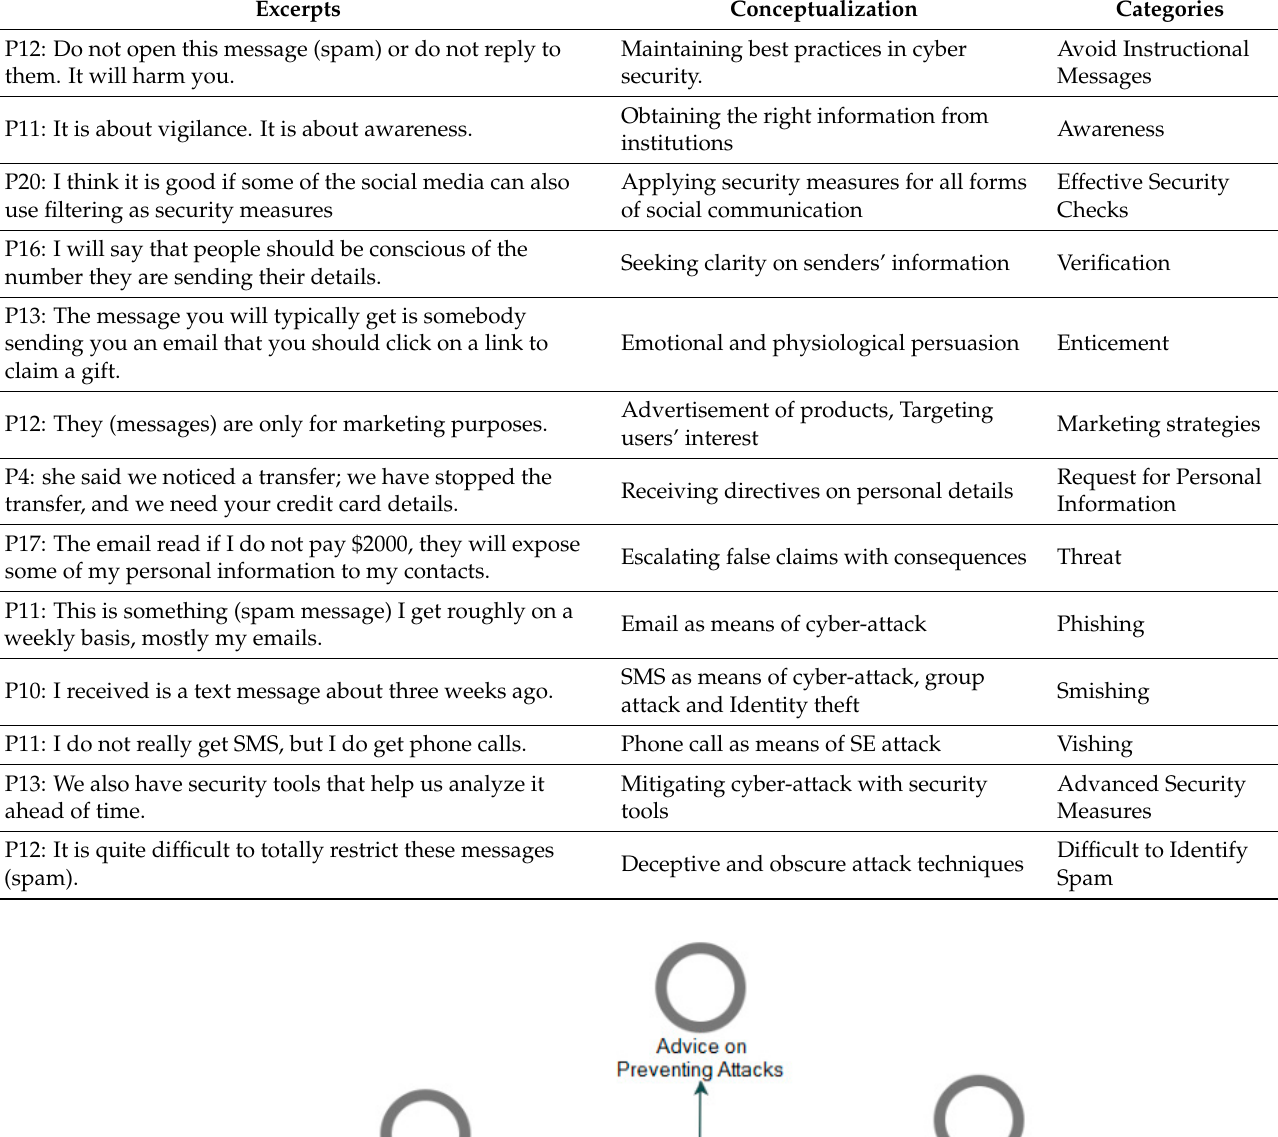
Table 1. Analysis of the open coding (with excerpts).